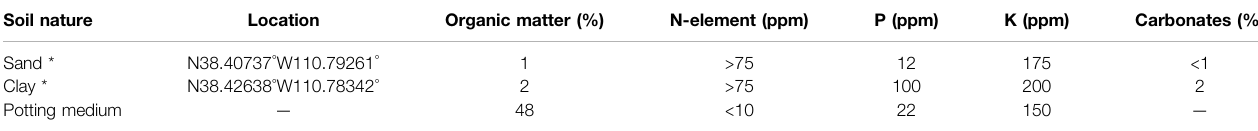
TABLE 1 | Characteristics of soils used in this study. * Soils sampled at the Mars Desert Research Station location, adapted from (Ehrenfreund et al., 2011). Soil nature